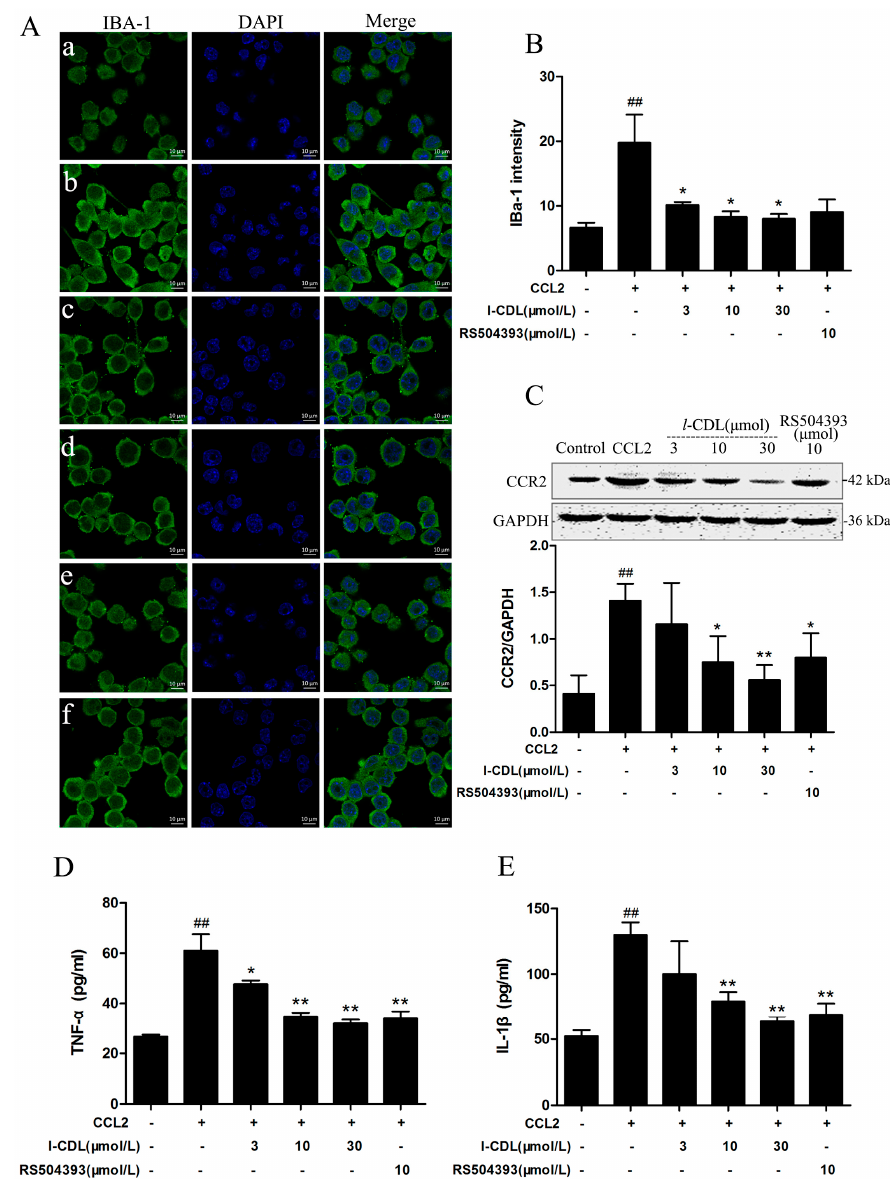
Figure 7. The effect of l -CDL on CCL2/CCR2 signal pathway in BV-microglia after pre-treatment with CCL2. BV-microglia were pre-treated with CCL2 (3 ng/mL) for 2 h, then incubated with l -CDL (3 μ M, 10 μ M, 30 μ M) and RS504393 (10 μ M) for 2 h. ( A ) BV-microglia stained with IBA-1 antibody. IBA-1 expression (green) in activated BV-microglia as observed using confocal microscopy. The blue staining represents DAPI. Scale bar = 10 μ m. ( a ) Control; ( b ) CCL2 (3 ng/mL); ( c ) CCL2 (3 ng/mL) + l -CDL (3 μ M); ( d ) CCL2 (3 ng/mL) + l -CDL (10 μ M); ( e ) CCL2 (3 ng/mL) + l -CDL (30 μ M); ( f ) CCL2 (3 ng/mL) + RS504393 (10 μ M); ( B ) Graph showing the mean fluorescence intensity for IBA-1; ( C ) Levels of CCR2 detected by western blotting, quantified and normalized to GAPDH levels. Each value was then expressed relative to the control, which was set to 1; ( D ) The level of TNF- α in cell culture supernatant; ( E ) The level of IL-1 β in cell culture supernatant. ## p < 0.01 vs. the control group; * p < 0.05, ** p < 0.01 vs. the CCL2 group (mean ± S.D., n = 3).